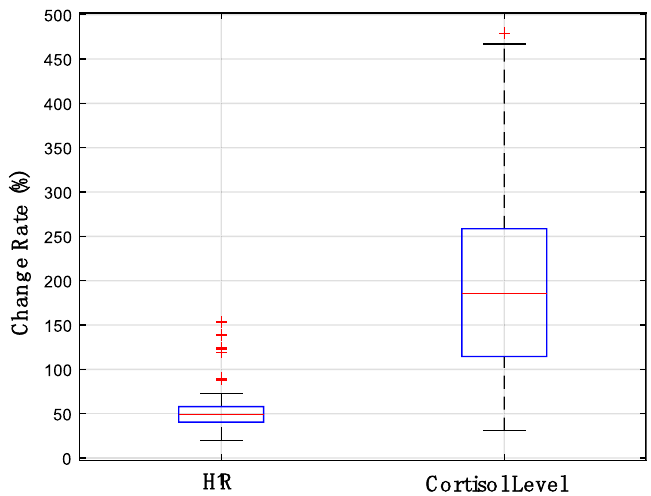
Figure 6. Change ranges of cortisol level and HR under stress